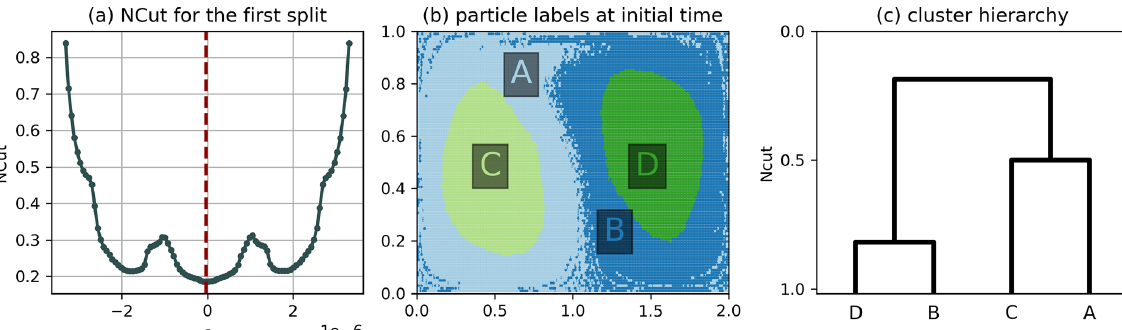
Figure B7. Hierarchical clustering result of the double gyre using algorithm 2 of Sect. 3.3 and (cid:49)x = (cid:49)y = 0 . 2. (a) NCut for the first split as a function of the cutoff c , where c = 0 corresponds to a cut along the transport boundary. (b) Result of the hierarchical clustering. (c) Dendrogram representing the hierarchy, where the horizontal lines correspond to the NCut value after each split. There is a global minimum at c = 0, so that the transport boundary is detected as the first